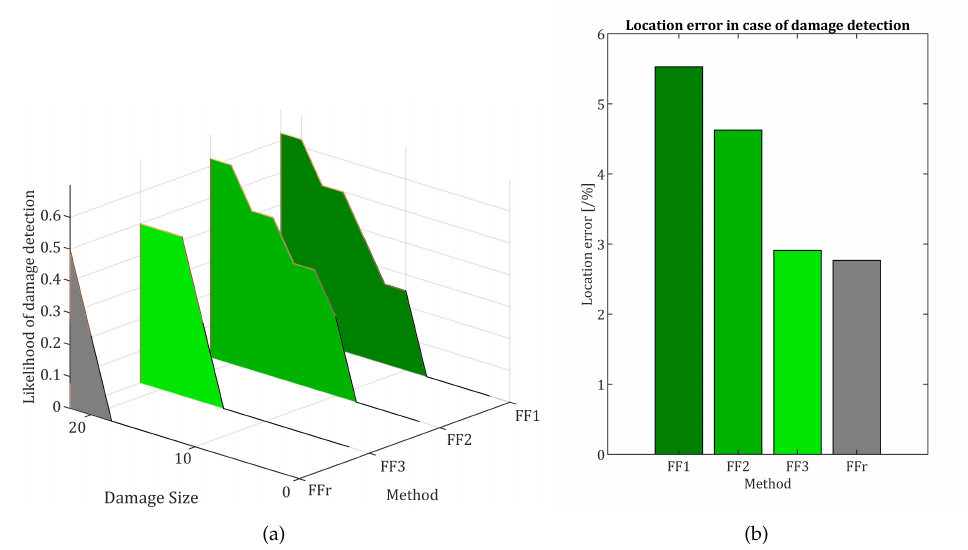
Figure 22. The results aggregated for all four methods under ivestigation: ( a ) damage location capabilities and damage detection capabilities in function of damage size and ( b ) damage location accuracy in the event of damage